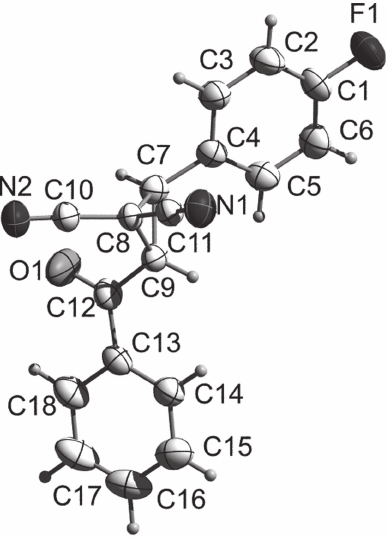
Table 1: Data collection and handling.